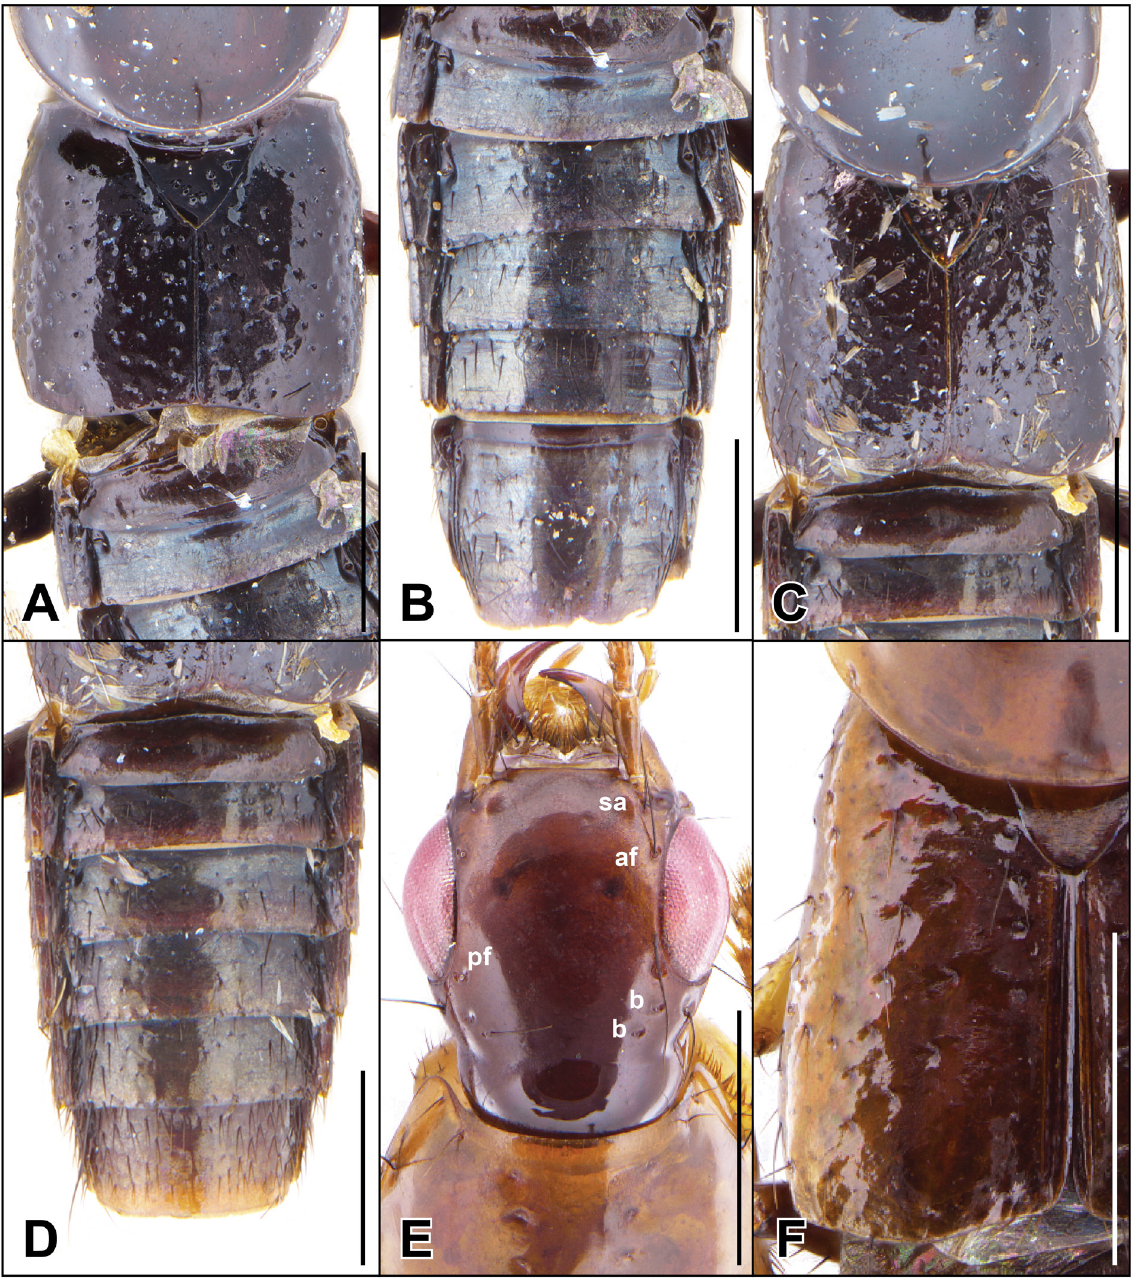
Fig. 4. A–B . Indoquedius dispersepunctatus (Scheerpeltz, 1965). A . Elytra. B . Dorsal abdomen. C–D . I. recticollis (Scheerpeltz, 1965). C . Elytra. D . Dorsal abdomen. E–F . Malaisdius smetanai gen. et sp. nov. E . Head. F . Elytra. Abbreviations: Af = anterior frontal puncture; b = basal puncture; pf = posterior frontal puncture; sa = supra- antennal puncture. Scale bars = 1